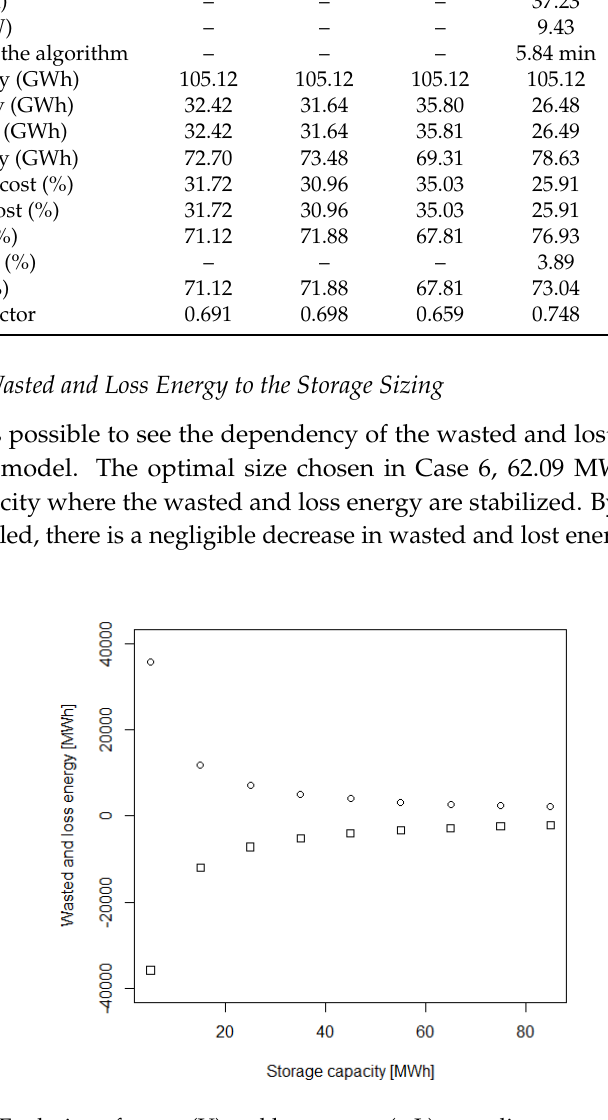
Figure 12. Evolution of wasted (U) and lost ( − L) energy according to power converter rating. There is a difference between the real values and the linear approximation presented in Section 2.2, but the approximation is conservative, because the wasted and lost energy is bigger in the approximation model than in the real model. 5.5. Sensitivity of the Storage Sizing to the Variability of the Input Power Storage systems must compensate the variability of the energy flow from the wind/wave energy farm. For the same flow, this variability depends on the considered time interval, in which the compensation is implemented. In Figure 13, the variability of power input in several time intervals 0